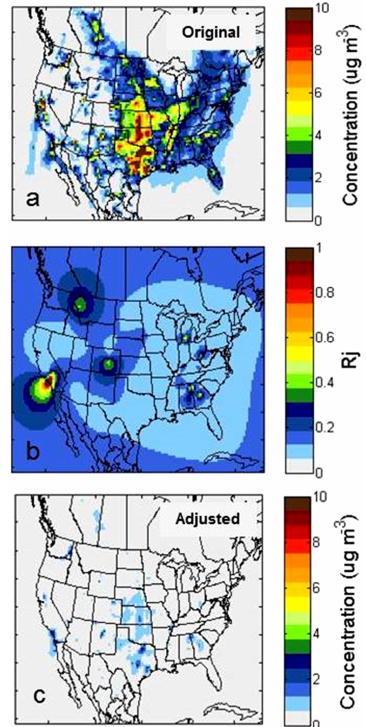
Figure 4. Hybrid-kriging adjustment of the dust impacts on PM 2 .